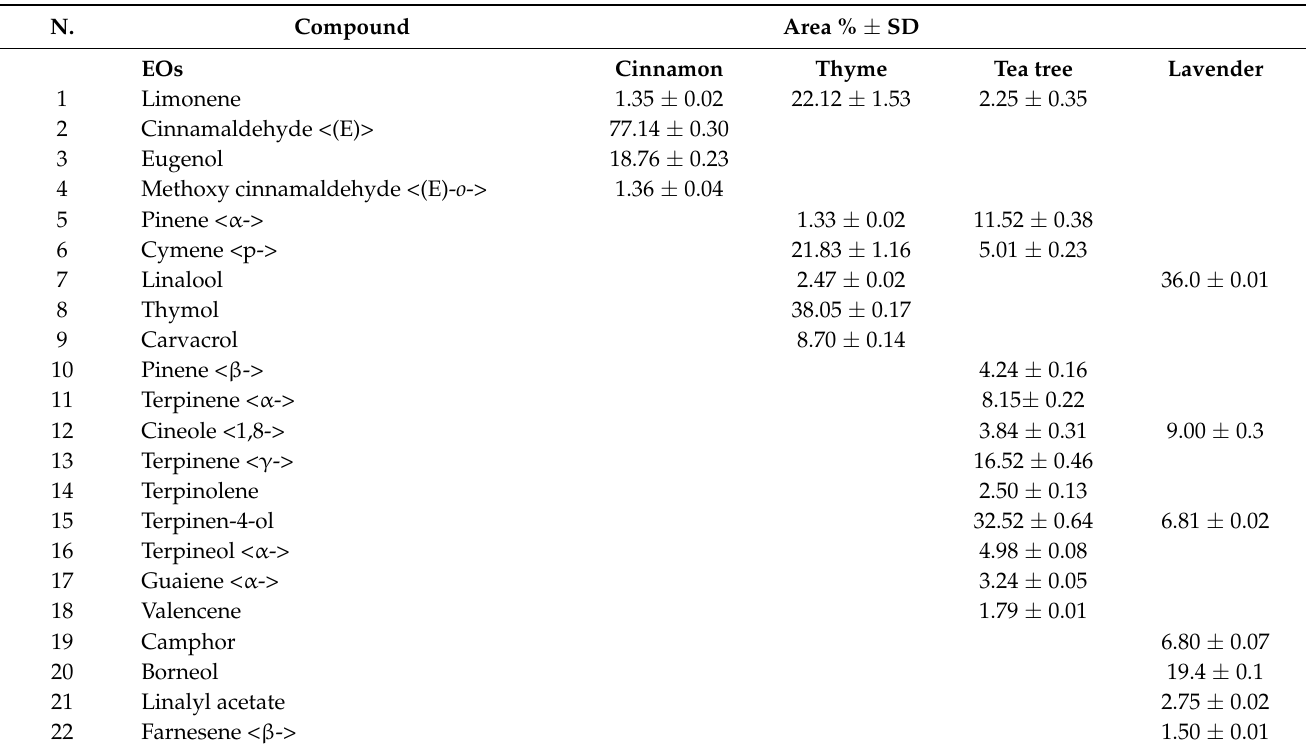
Table 1. Main chemical composition (>1.0%) of the three commercial EOs (cinnamon, thyme, tea tree) compared to L. angustifolia natural extract. Lavender EO was previously characterized